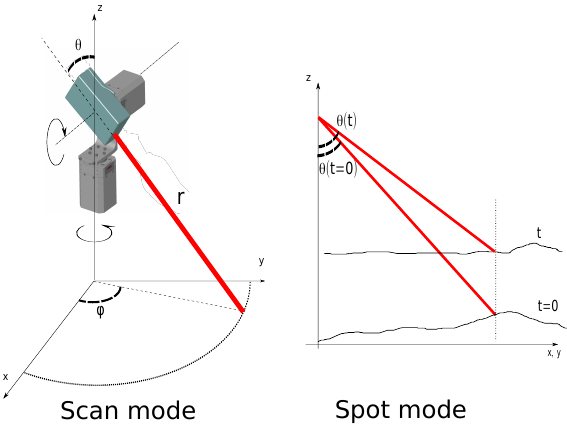
Figure 1. Principle of the scan mode and spot mode of the Rugged Laser Scan (RLS). The zenith angle θ and azimuth angle φ deter- mine the orientation of the laser meter which measures the range r